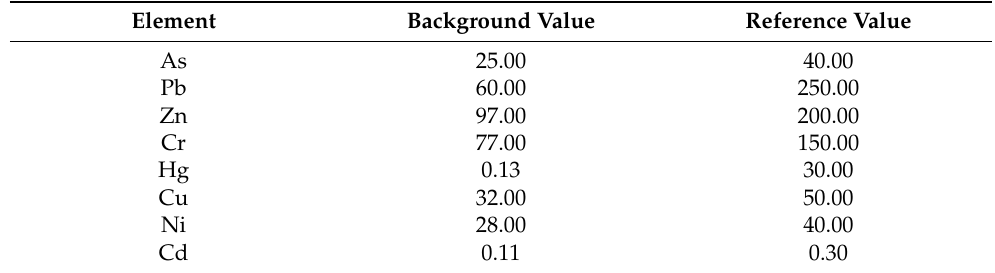
Table 1. Background and reference values of heavy metals in soil of Pearl River Basin (mg/kg). Element Background Value Reference